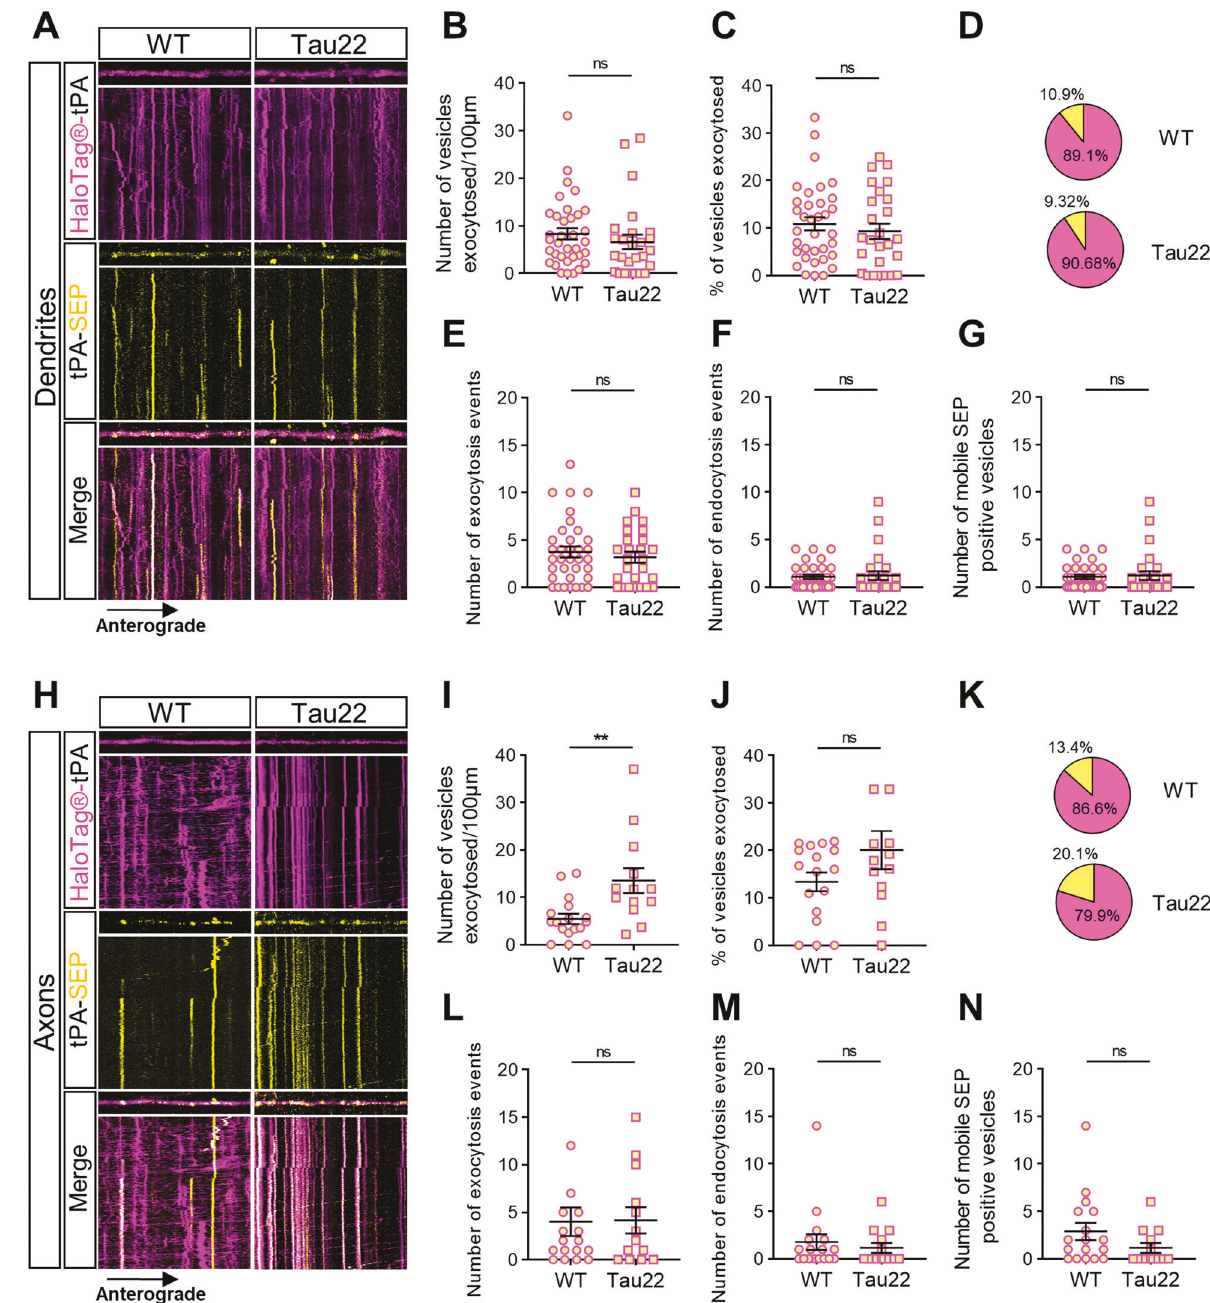
Fig. 8 Tauopathy increases exocytosis of axonal tPA. A , H Representative stacks of processes time lapse and their associated kymographs displaying HaloTag ® -tPA-SEP in WT and Tau22 neurons in dendrites ( A ) and in axons ( H ). All processes shown in ( A , H ) measure 40 µm, and all kymographs represent 40 µm horizontally and 10 min vertically. B Number of vesicles exocytosed per 100 µm in dendrites. C Number of vesicles exocytosed (SEP positive) as the ratio of the total pool of tPA vesicles (TMR-HaloTag ® positives) on dendrites. D Pie charts representing the percentage of exocytosed HaloTag-tPA-SEP vesicles (SEP positive, in yellow) and intracellular HaloTag-tPA-SEP vesicles (SEP negative, in magenta) in dendrites. E , F Number of tPA-SEP exocytosis ( E ) and endocytosis ( F ) events observed in basal conditions. G Number of dendritic motile tPA-SEP positives vesicles. ( B – G ) WT n = 20 and Tau22 n = 19 ( C , D ) from 3 independent cultures. I Number of vesicles exocytosed per 100 µm in axons. J Number of vesicles exocytosed (SEP positive) as ratio of the total pool of tPA vesicles (TMR-HaloTag ® positives) on axons. K Pie charts representing the percentage of exocytosed HaloTag-tPA-SEP vesicles (SEP positive, in yellow) and intracellular HaloTag-tPA-SEP vesicles (SEP negative, in magenta) in axons. L , M Number of tPA-SEP exocytosis ( L ) and endocytosis ( M ) events observed in axons in basal conditions. N Number of axonal motile tPA-SEP positives vesicles. I – N WT n = 14 and Tau22 n = 13 ( C , D ) from 3 independent cultures. B – G , I – K Samples were drawn from at least three independent experiments. Statistical tests: two-tailed Mann – Whitney test, ** p < 0.01, ns not signi fi cant. Kymograph scales: x = 40 µm, y = 10